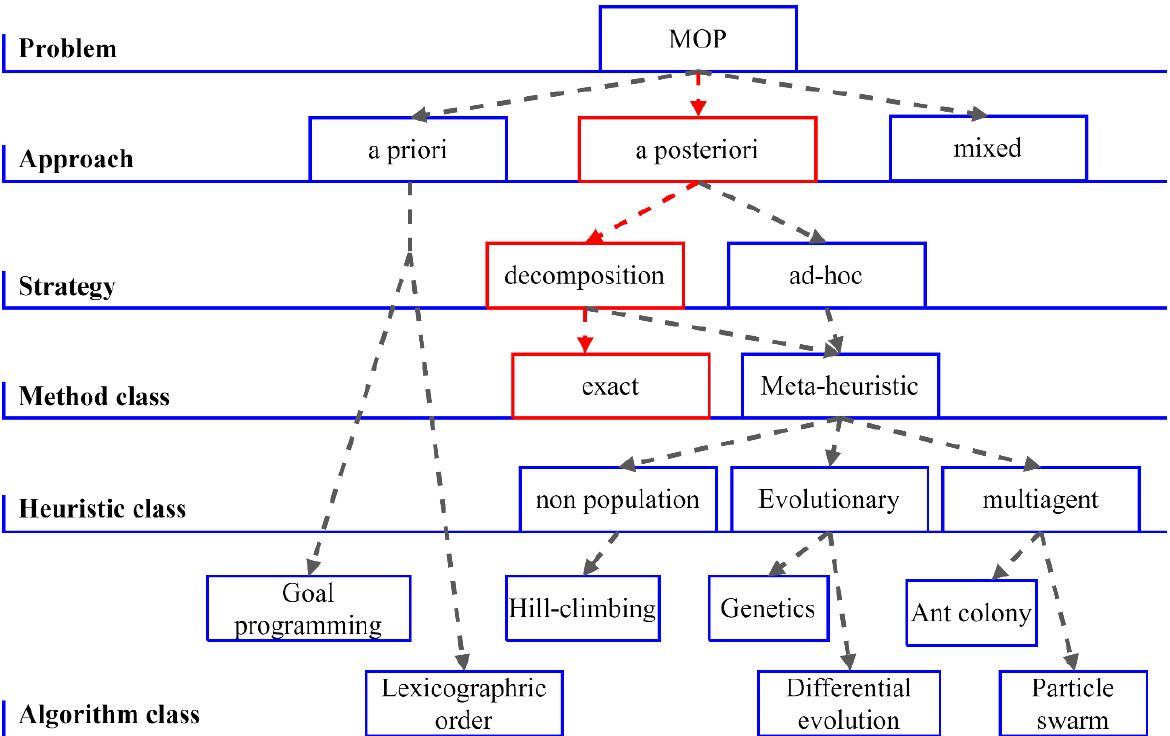
Figure 7. Approximations to solve the MOP. In red, the route proposed in this work.